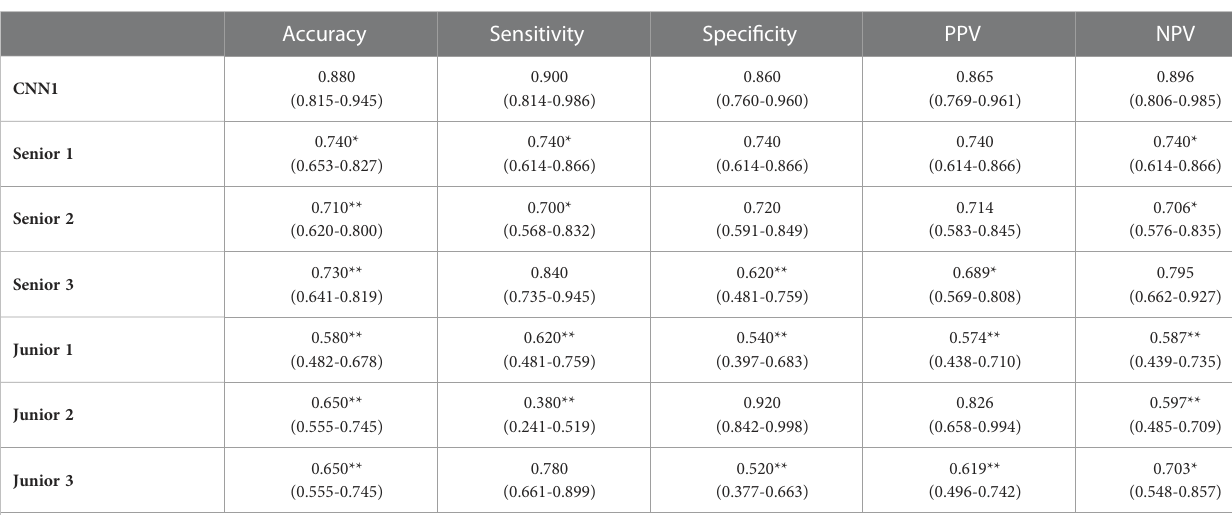
TABLE 4 Diagnostic performance for GNLs by each